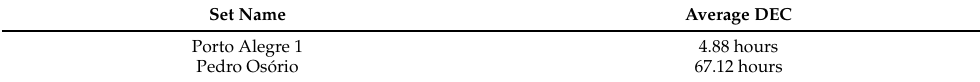
Table 20. Best and worst set (aerial networks) based on average DEC.